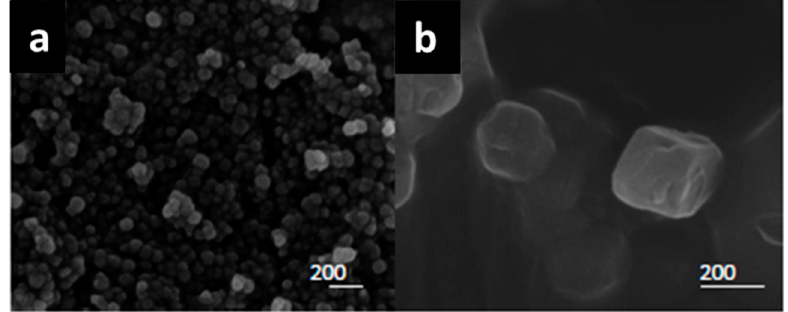
Figure 5. Scanning Electron Micrograph images of ( a ) ZIF-8 and ( b ) ZIF-8-HT. The scale bar represents 200 nm in each image.